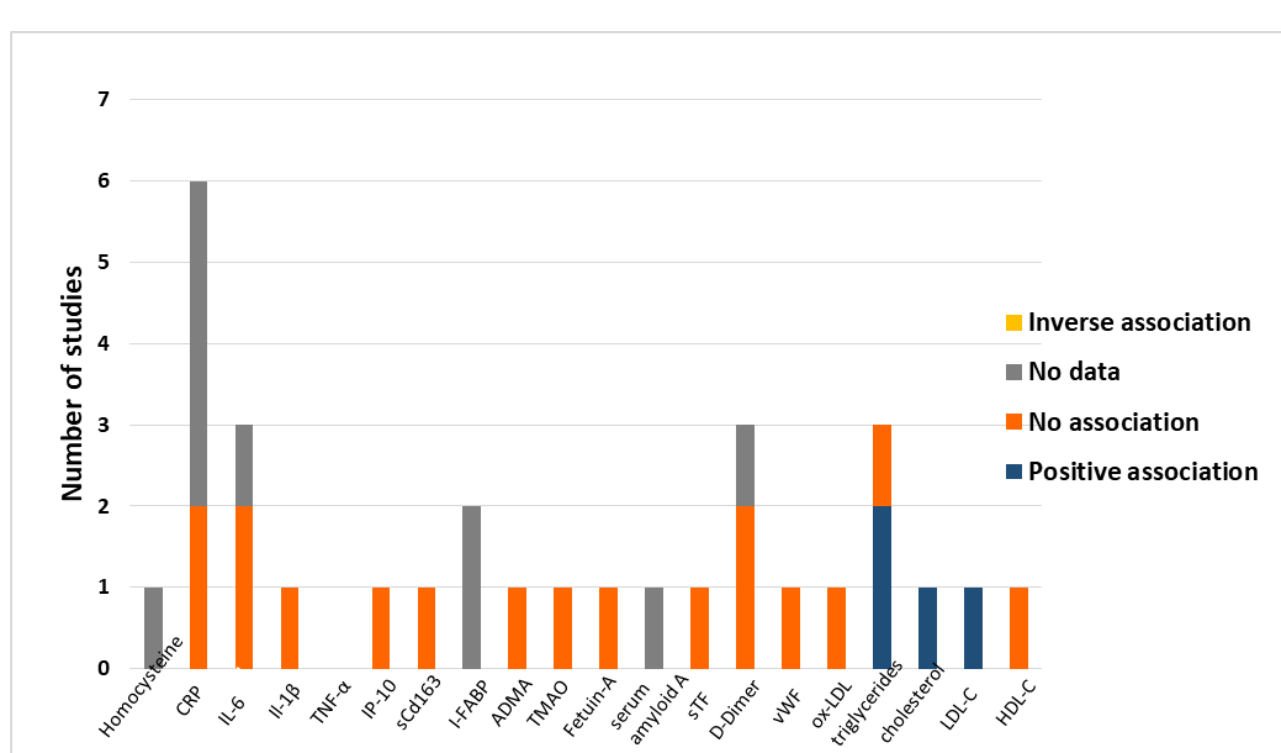
FIGURE 4 - Association between LPS microbial translocation biomarker and biomarkers of inflammation and cardiovascular risk. LPS, lipopolysaccharides; CRP, C-reactive protein; IL-6, interleukin-6; IL-1 β , interleukin 1 β ; TNF- α , tumor necrosis factor-alpha; IP-10, interferon- γ -inducible protein 10; sCD163, soluble CD163; I-FABP, intestinal fatty acid binding protein; ADMA, asymmetric dimethylarginine; TMAO, trimethylamine-N-oxide; sTF, soluble tissue factor; vWF, von Willebrand factor; oxLDL, oxidized LDL